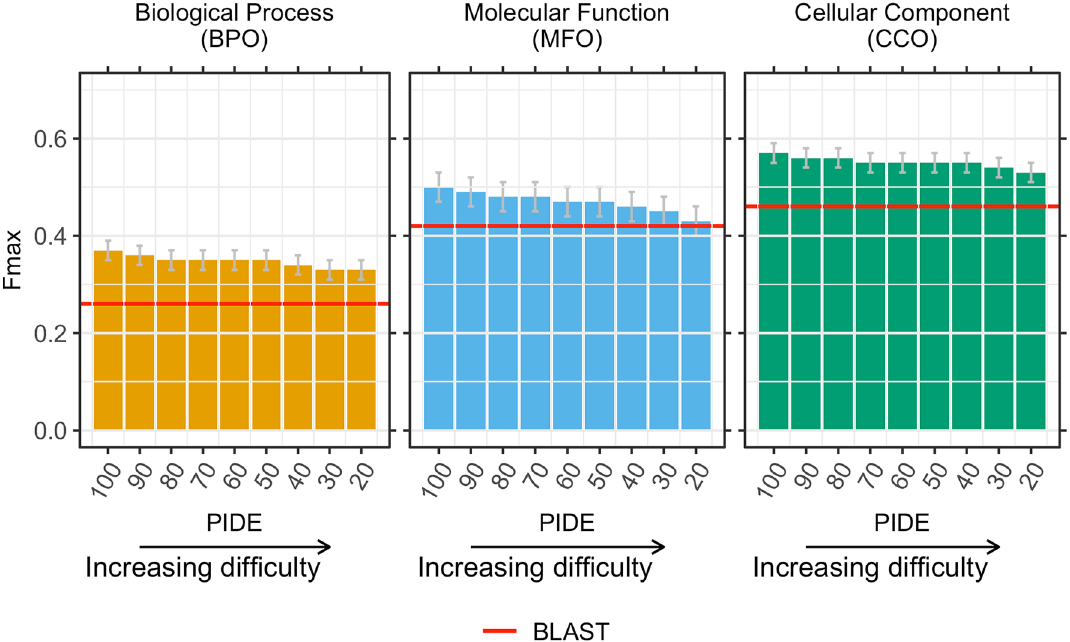
Figure 2. Embedding-based transfer succeeded for rather diverged proteins. After establishing the low correlation between embedding- and sequence-similarity, we tested how the level of percentage pairwise sequence identity (PIDE, x-axes) between the query (protein without known GO terms) and the transfer database (proteins with known GO terms, here subsets of GOA2017 ) affected the performance of the embedding-based transfer. Technically, we achieved this by removing proteins above a certain threshold in PIDE (decreasing toward right) from the transfer database. The y-axes showed the F max score as compiled by CAFA3 19 . If embedding similarity and sequence identity correlated, our method would fall to the level of the reddish lines marked by BLAST. On the other hand, if the two were completely uncorrelated, the bars describing embedding-transfer would all have the same height (at least within the standard errors marked by the gray vertical lines at the upper end of each bar), i.e., embedding-based transfer would be completely independent of the sequence similarity between query and template (protein of known function). The observation that all bars tended to fall toward the right implied that embedding and sequence similarity correlated (although for CCO, F max remained within the 95% confidence interval of F max for GOA2017-100 ). The observation that our method remained mostly above the baseline predictions demonstrates that embeddings capture important orthogonal information. Error bars indicate 95% confidence